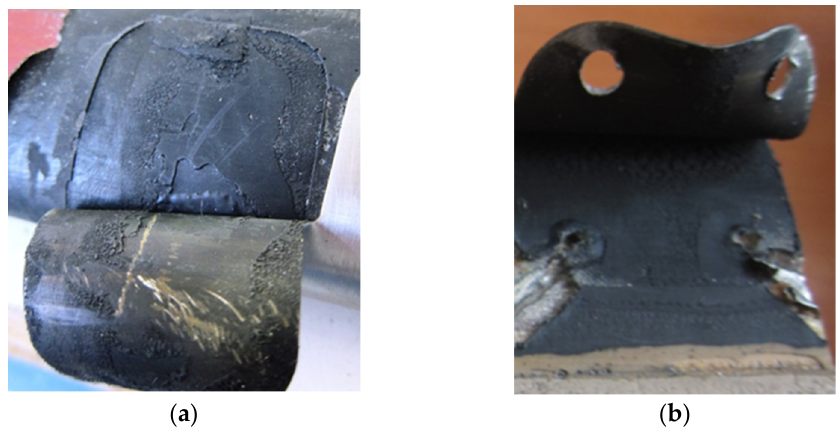
Figure 8. Fracture surfaces of bonding layers: ( a ) Bonding ply with voids—wet adhesive paste was not properly applied; ( b ) Bonding ply without voids—wet adhesive paste was correctly applied.